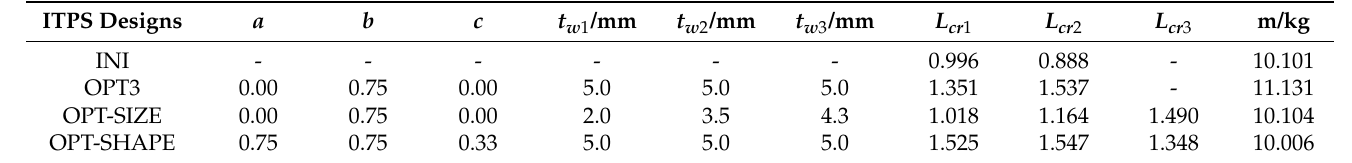
Table 6. Geometric parameters and critical load factors for 3D optimized designs.